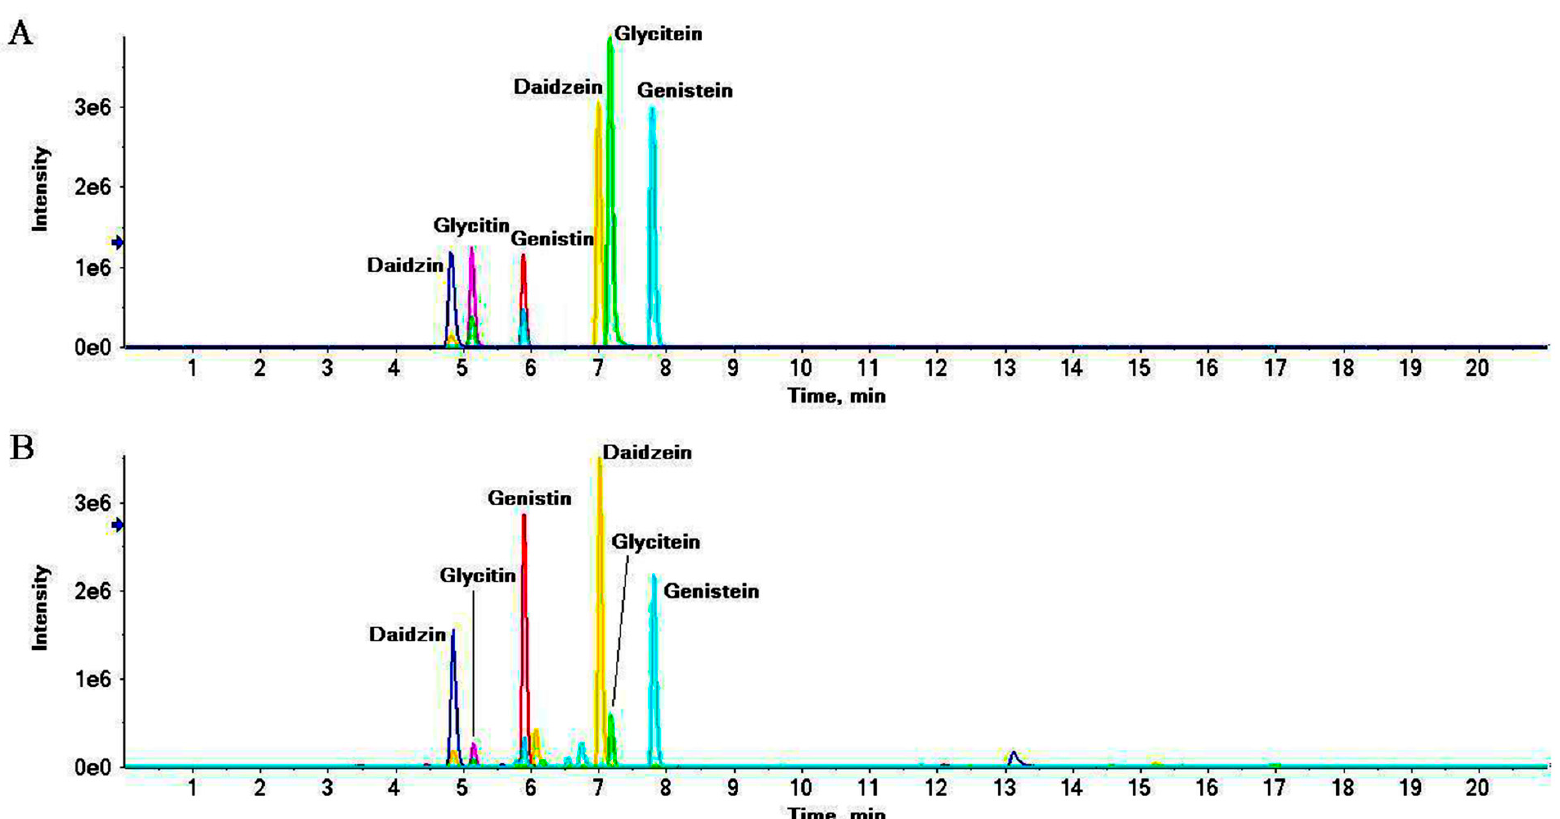
Figure 5. Representative extract ions chromatograms (XIC) of mix standard solution ( A ) and S8 ( B ) at m / z 417.118 ± 0.02 (daidzin), 447.129 ± 0.02 (glycitin), 433.113 ± 0.02 (genistin), 255.065 ± 0.02 (daidzein), 285.076 ± 0.02 (glycitein) and 271.060 ± 0.02 (genistein).